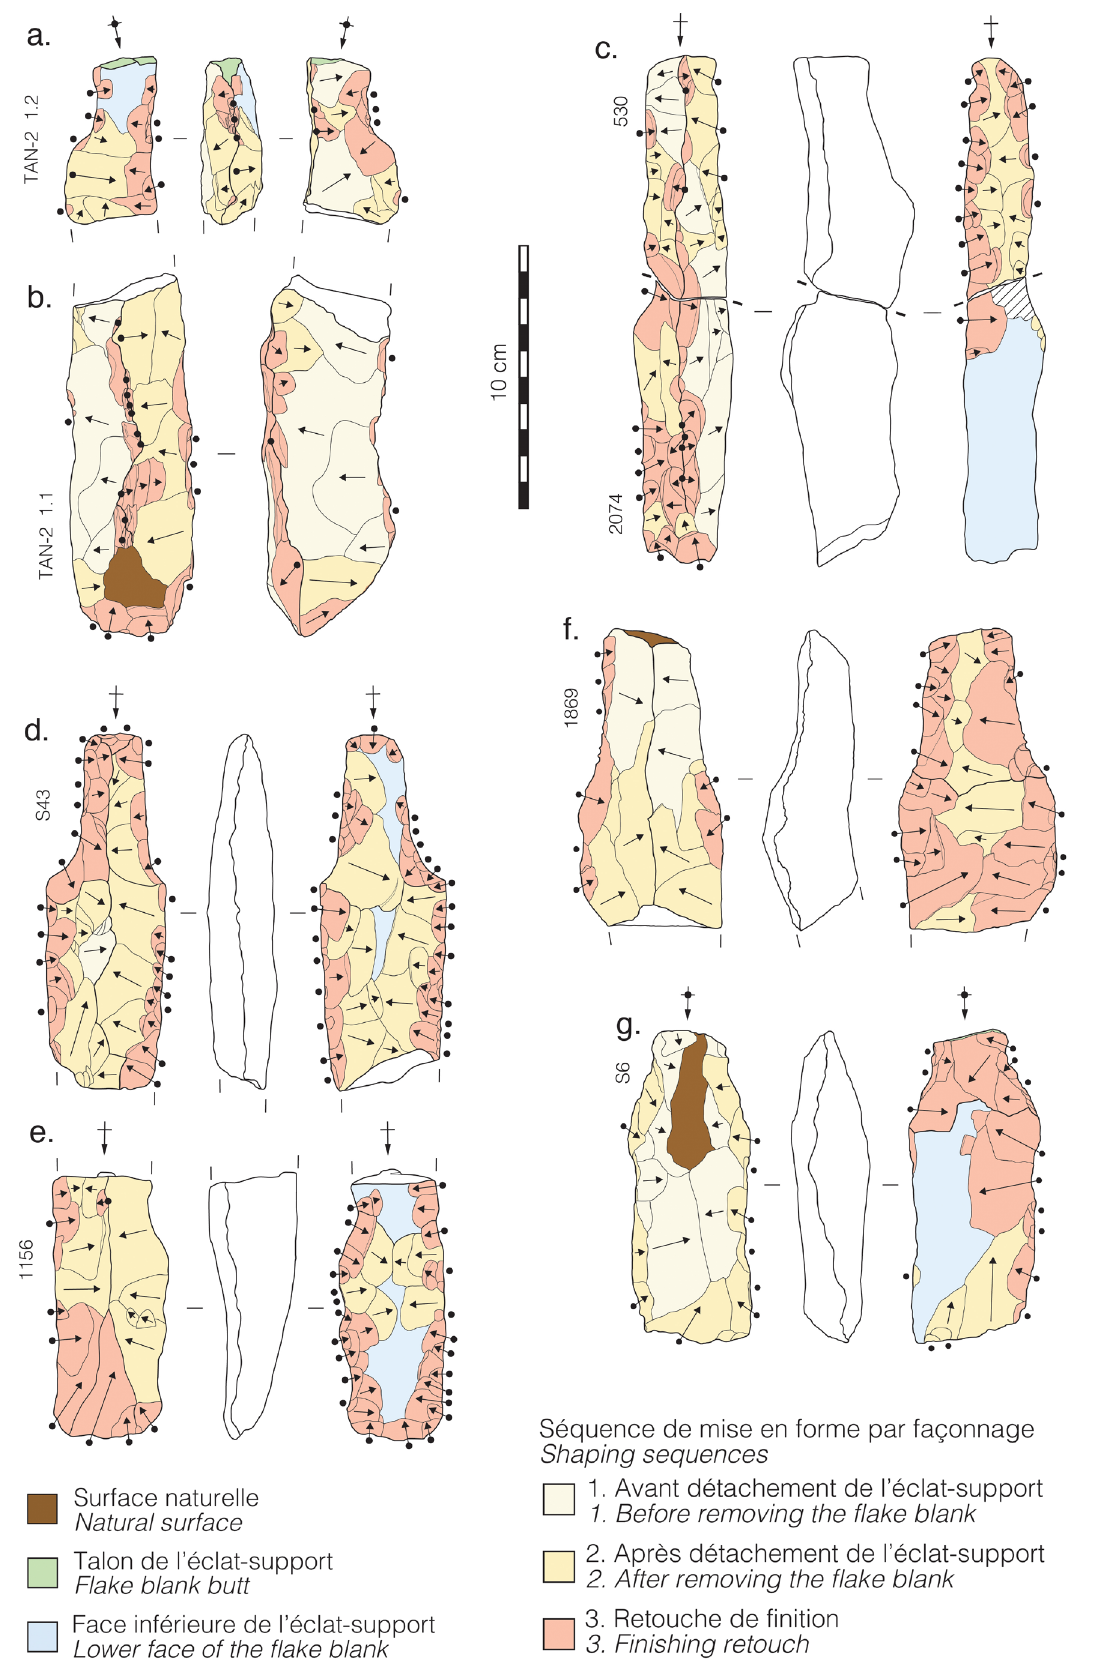
Figure 14. Schéma diacritique des préformes de lame à Tanataetea. Figure 14. Diacritical sketch of Tanataetea adze